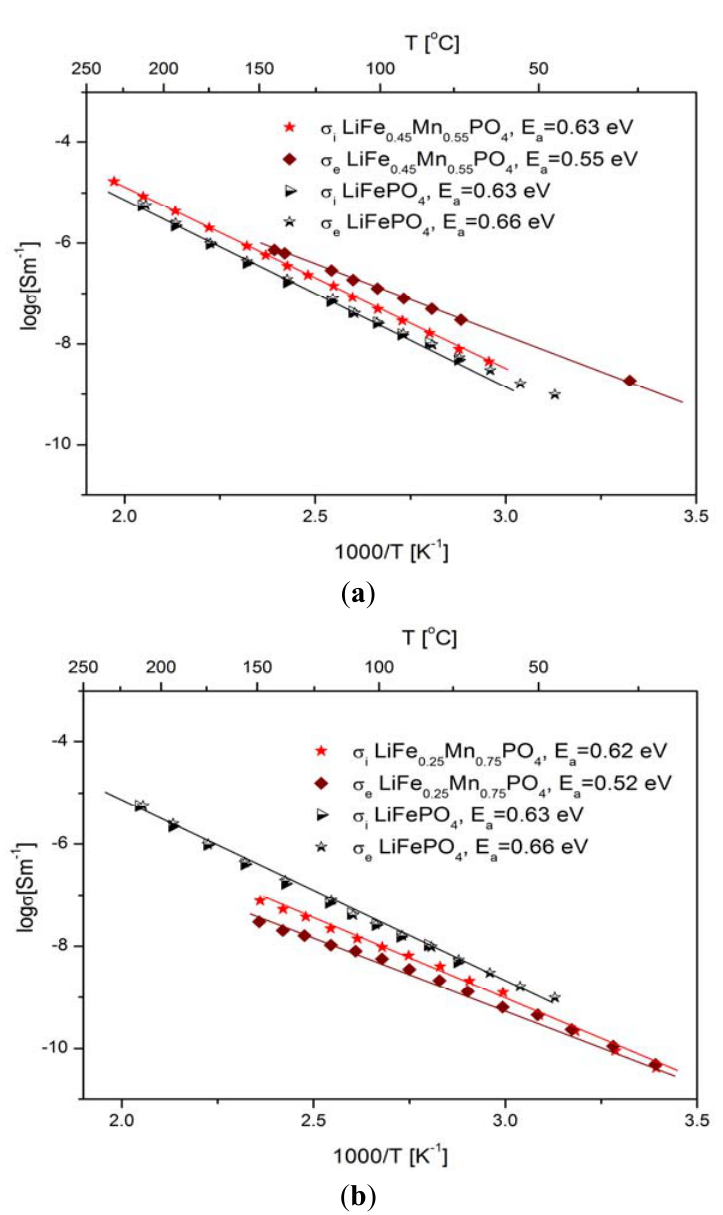
Figure 25. Temperature dependence of electronic and ionic component of electrical conductivity for LiFe taken from